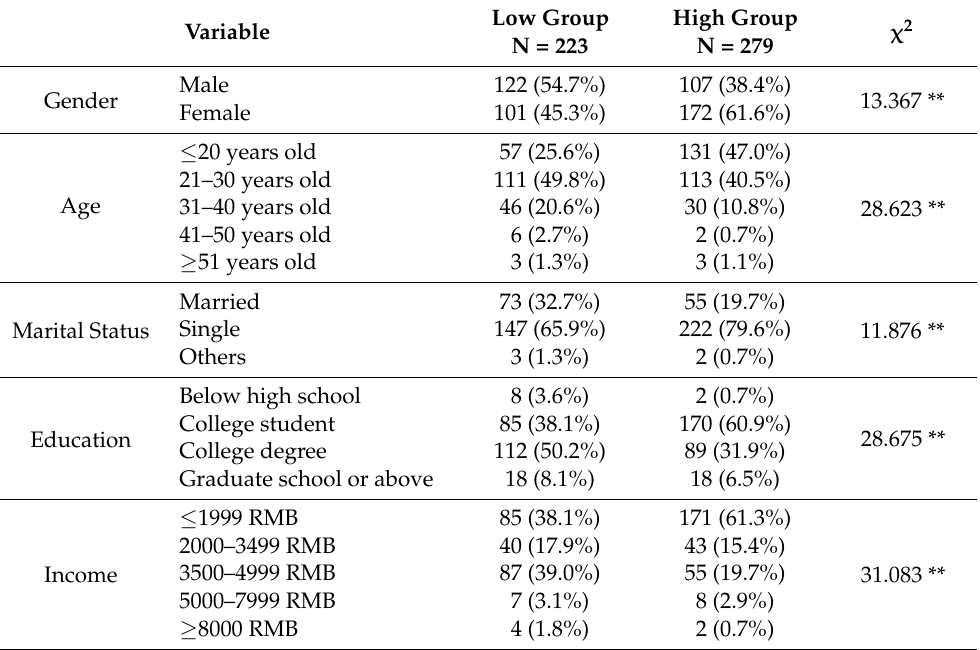
Table 8. Summary of crosstab